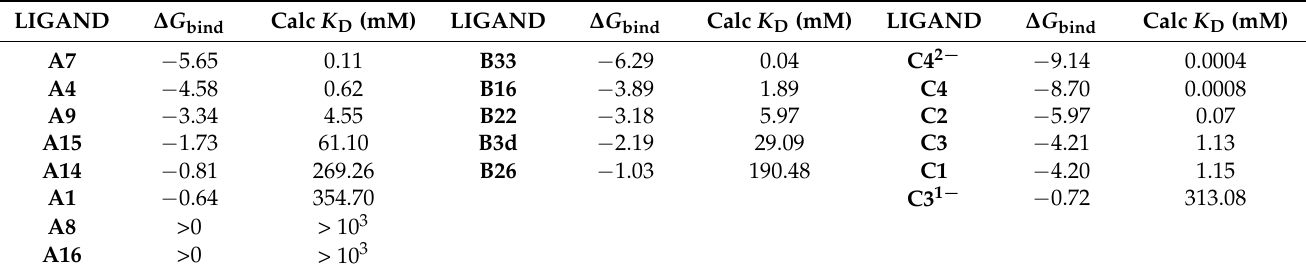
Table 1. Computed ∆ G bind (kcal · mol − 1 ) and calculated K D values for ligands of libraries A, B